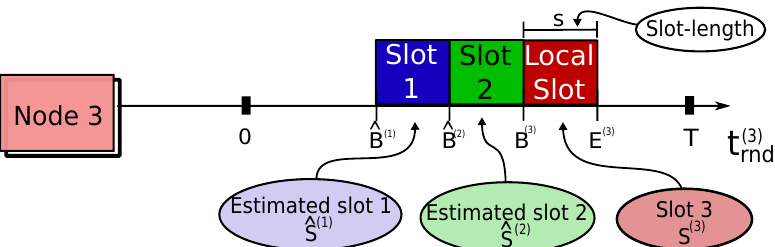
Figure 6. The node with slot ID 3 (red) estimates boundaries of slots ID 1 (blue) and ID 2 (green), by using Equation (5).